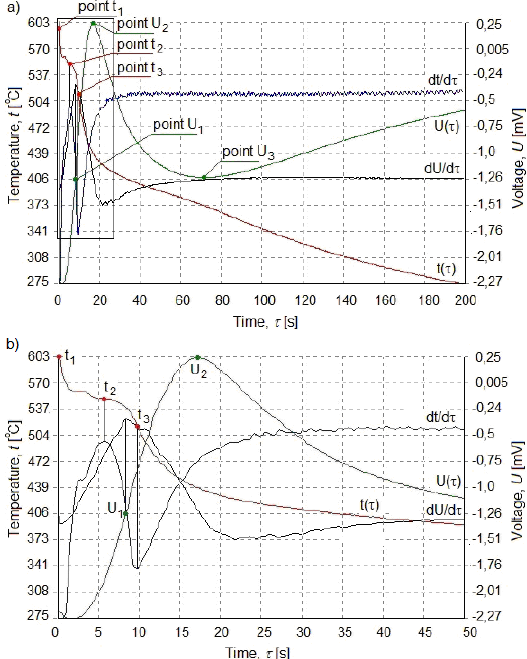
Fig. 3. Curves from the ATND method with marked characteristic points for the investigated alloy: a) complete run of the crystallization process, b) magnification of the marked area [26]